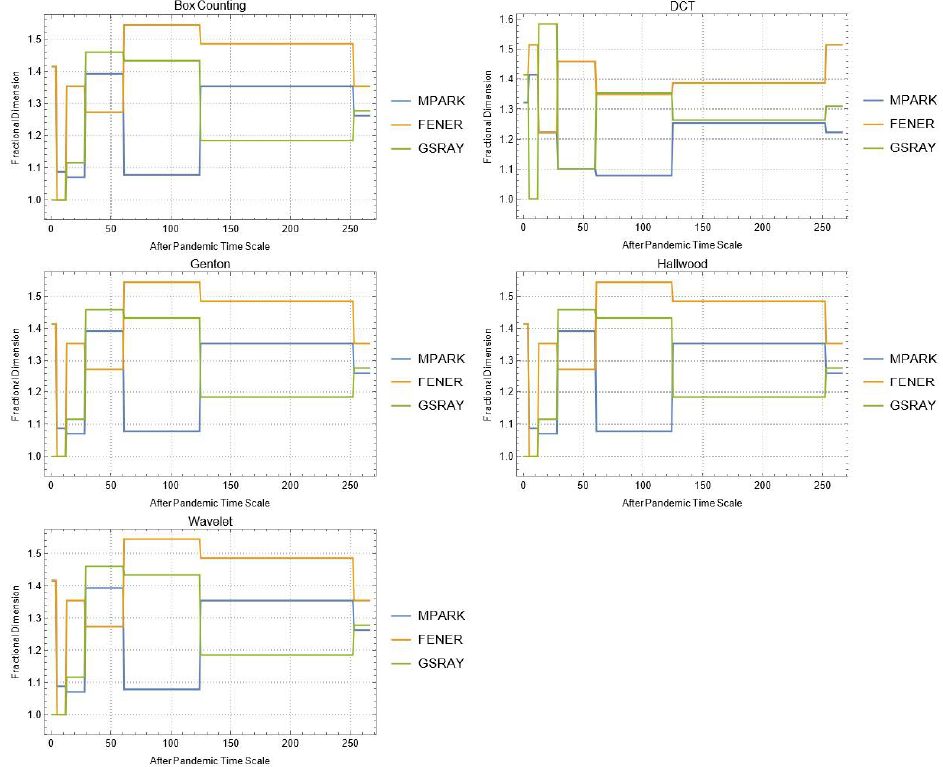
Figure A15. Daily changes of fractal dimensions after the pandemic (social).